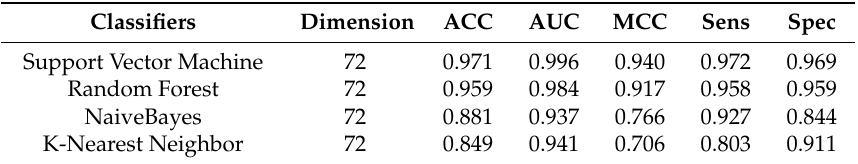
Table 2. Comparison of four commonly used classifiers using independent testing on IT-set. MCC is the abbreviation of Matthew’s Coefficient Of Correlation; Sens is the abbreviation of sensitivity; Spec is the abbreviation of specificity.